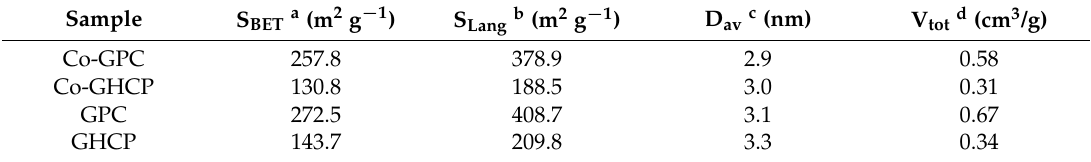
Figure 3. ( a ) Nitrogen adsorption/desorption isotherm plot and ( b ) the Barrett–Joyner–Halenda (BJH) pore-size distribution curve of GHCP, GPC, Co-GHCP, and CPC. Table 1. Nitrogen physisorption property of the prepared porous materials.